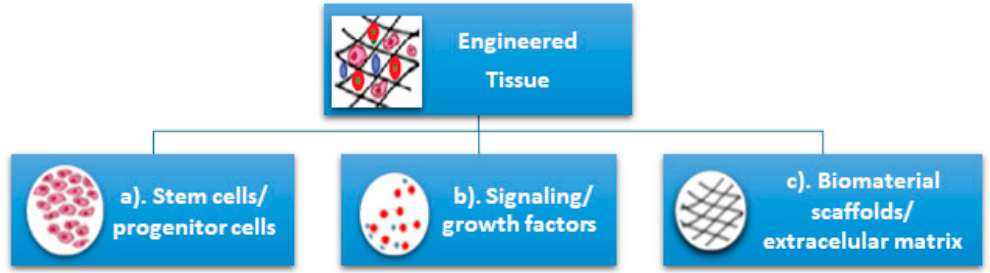
Figure 1. Classical pillars of tissue engineering: ( a ) the cells (stem cells/progenitor cells), ( b ) the signaling/growth factors, ( c ) the biomaterial scaffolds/extracellular matrix.